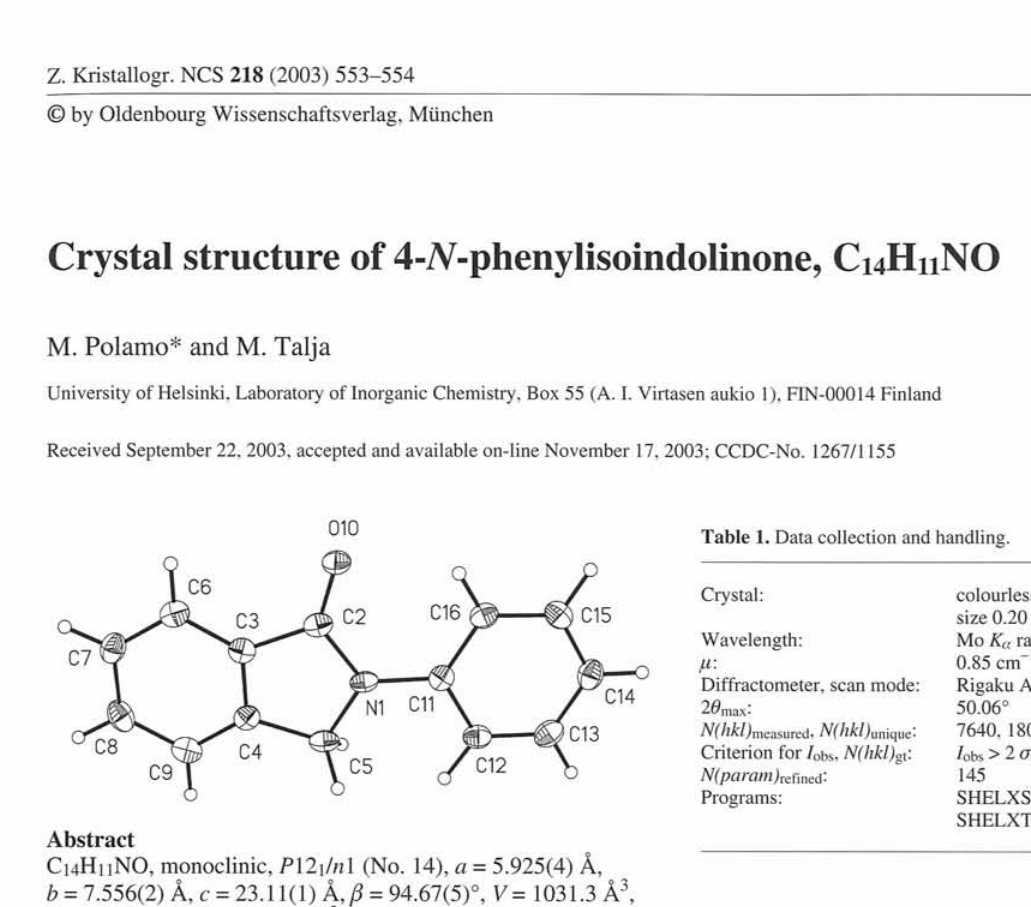
Table 1. Data collection and handling.